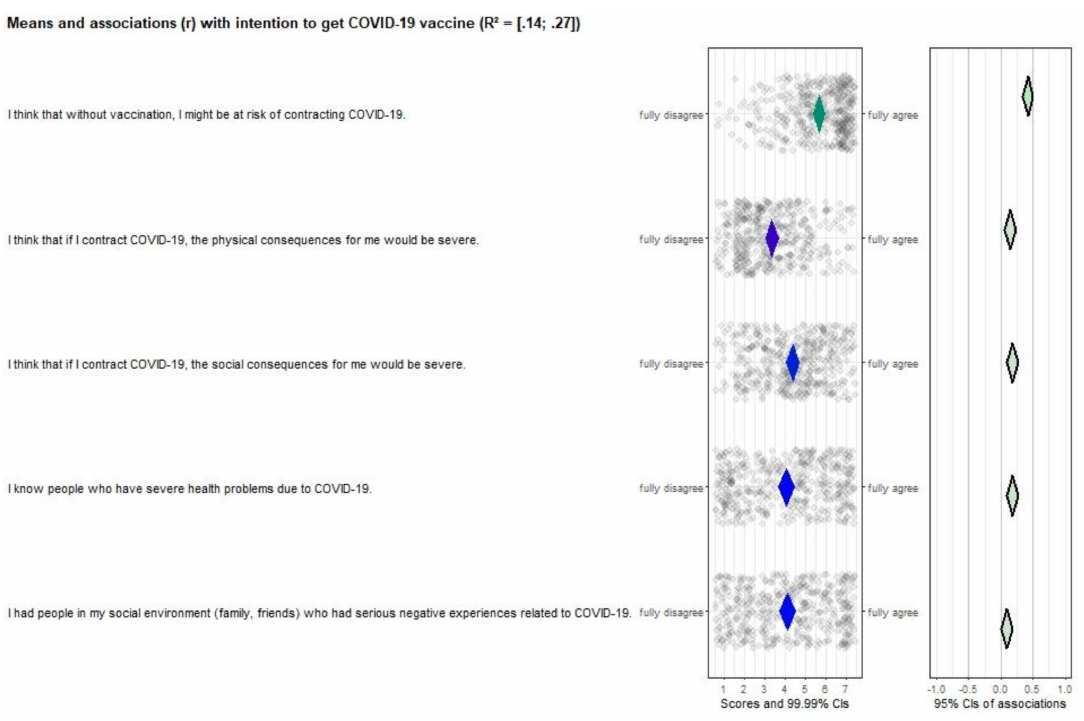
Figure 2. CIBER plot of risk perception visualizing means and association with intention to get the COVID-19 vaccine.